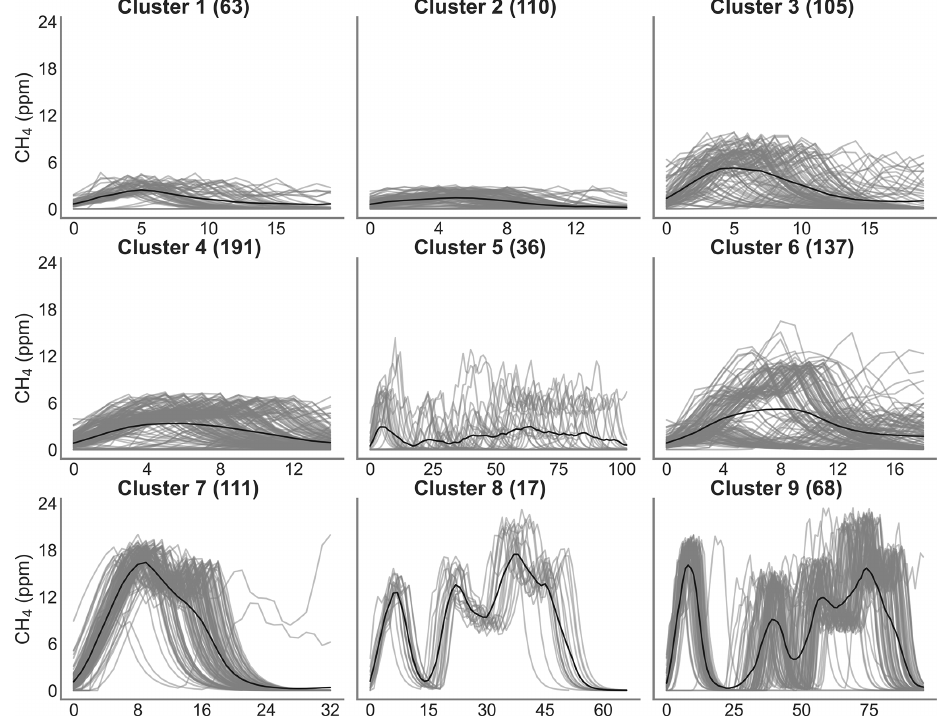
Figure 8. Clustering of peaks using DTW on the reference instrument. On the title of each plot, the number inside the parentheses corresponds to the number of spikes attributed to each cluster. Thin gray lines represent all the peaks inside each cluster, and the black line is the mean of all the peaks corresponding to each